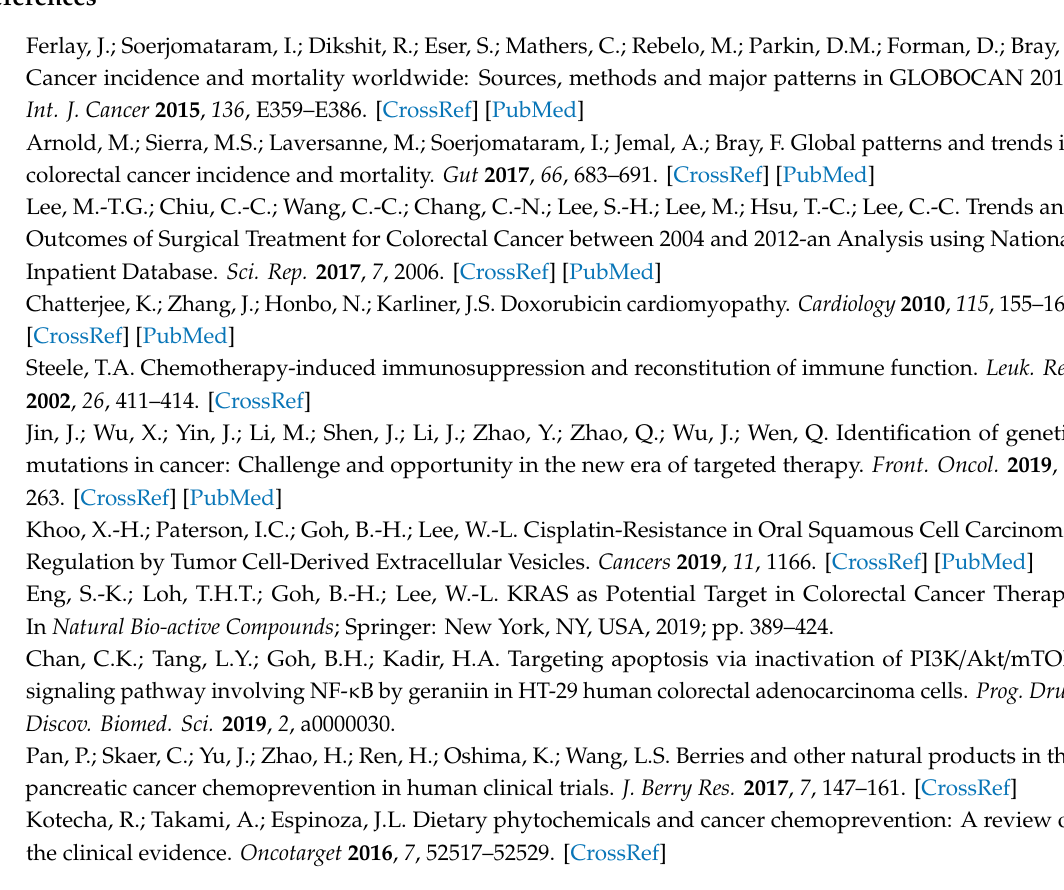
Figure S1: The Western blot of protein of interest (p21 and cyclin B) and respective β -actin expressions, Figure S2: Cytotoxic e ff ects of the two main compounds (3) and (6) on HT-29 colon cancer cells. Author Contributions: The writing was performed by L.T.-H.T., P.P., L.-H.L. and B.-H.G. While C.-K.C.,